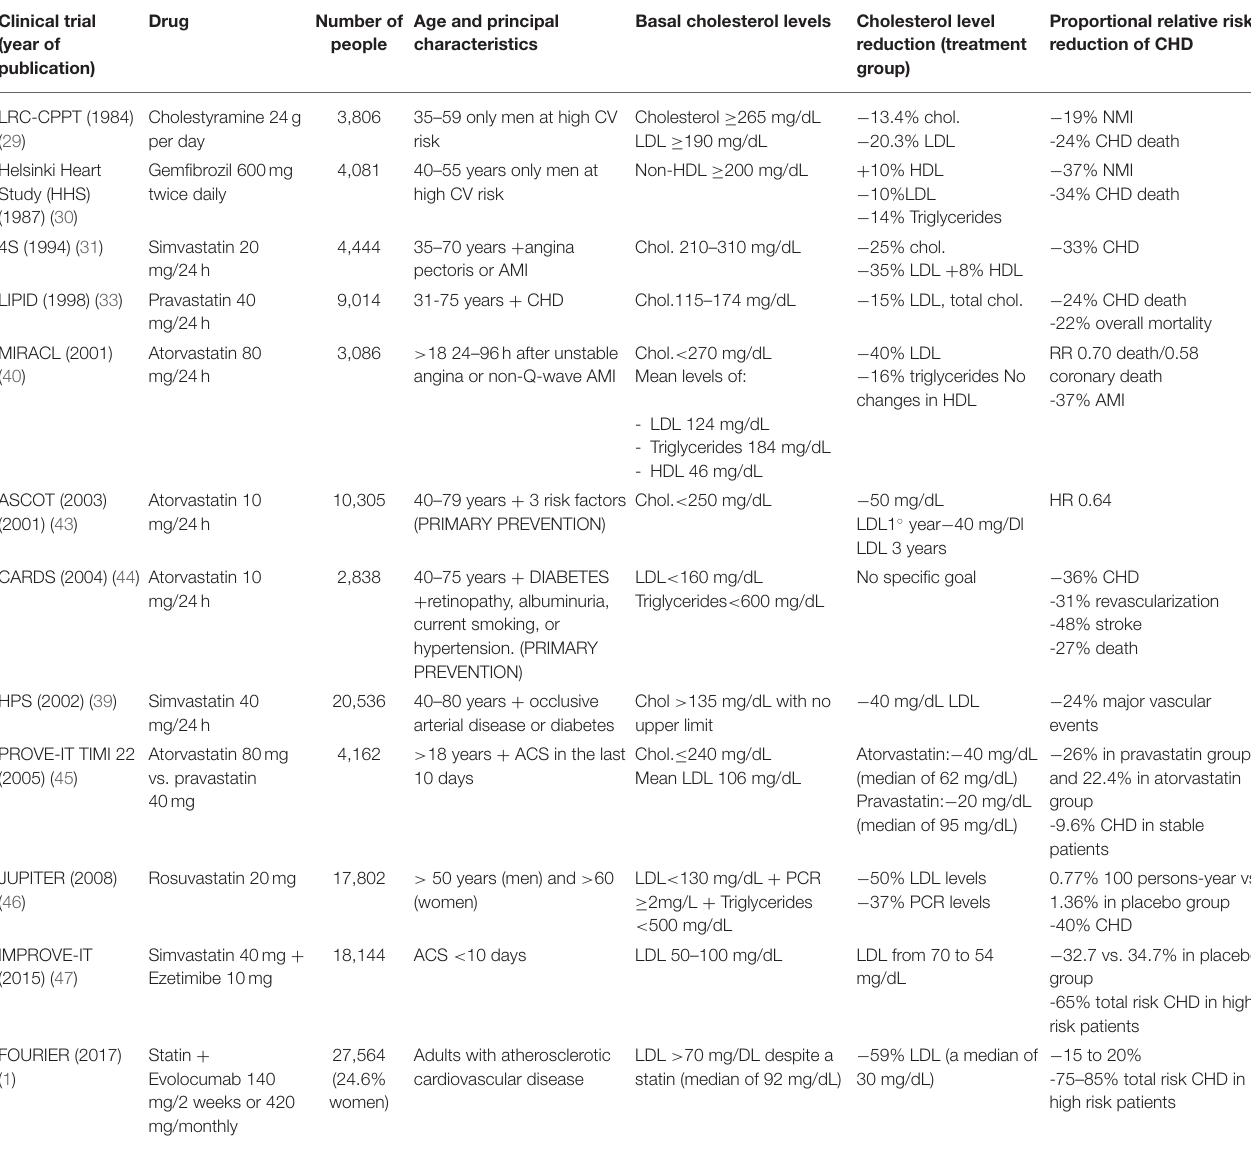
TABLE 2 | Clinical trials showing the benefits of both lipid-lowering drugs prior to statins and statins in the reduction of cardiovascular events and mortality. Clinical trial (year